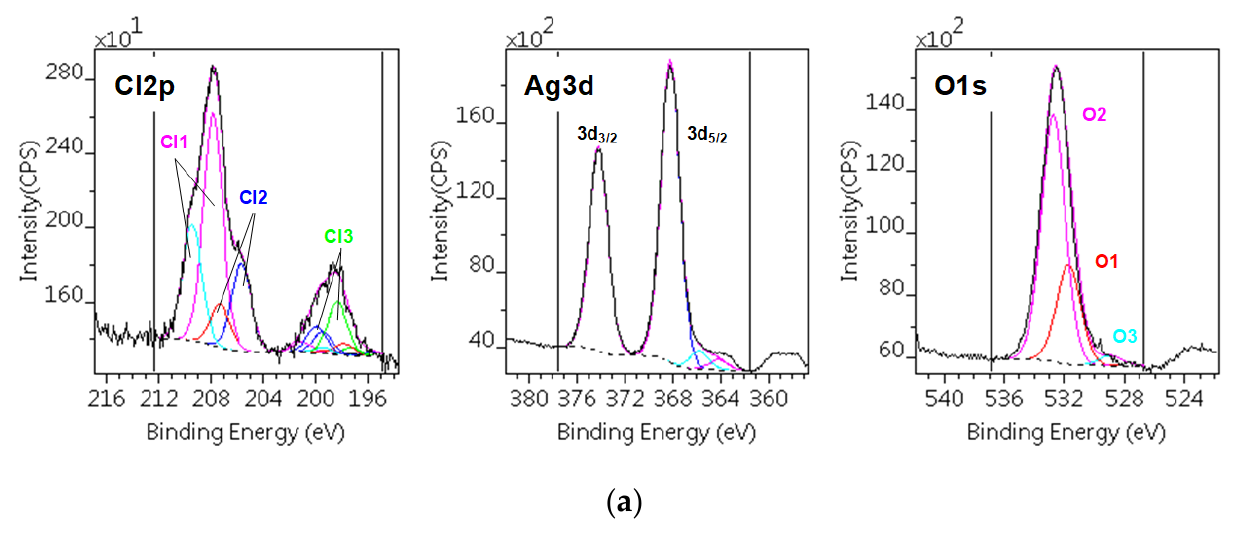
Figure 12. The IR spectroscopic study of the decomposition of the I-240 The relative amount of perchlorate, chlorate, and chloride ions in the samples I-240 and aq. extract of I-240 were found to be 8.25:3.35:1 and 8.02:3.01:1, respectively. The chlorite intermediate contents of the two samples are close to each other, and ca. 1/4 of the compounds containing chlorine proved to be chlorate ions on both sample surfaces. The silver XPS signals (368.3 and 368.5 eV) are the same for all three expected component types (AgCl, AgClO 3 , and AgClO 4 or their complexes with ammonia). The oxygen signals of chlorate and perchlorate ions could easily be distinguished (531.2–531.9 eV: chlorate, and 532.8 eV: perchlorate) (Figure 13).